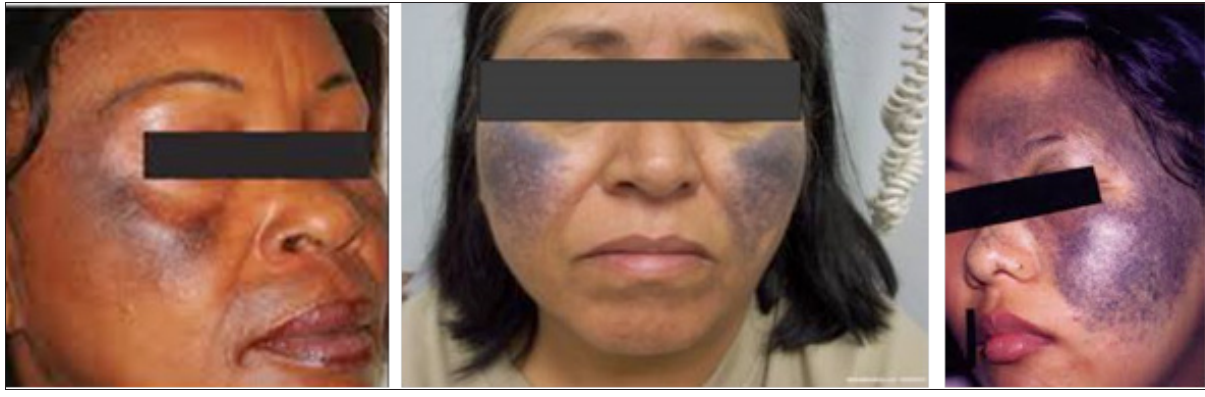
Figure 1: Evidence of exogenous ochronosis resulting from chronic use of skin lightening